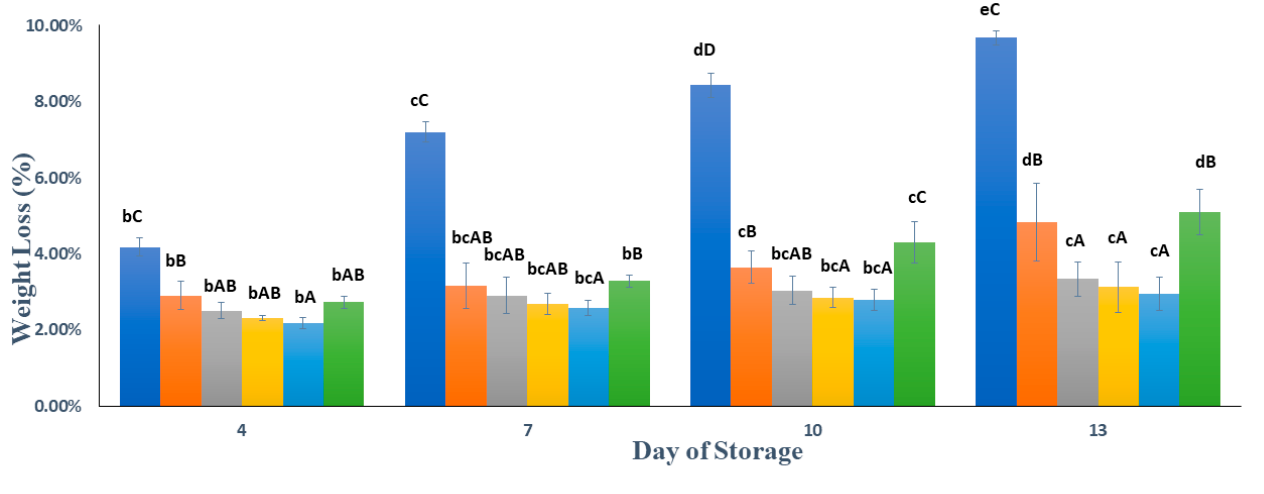
Figure 2. Effect of an edible coating of gelatin composite enriched with black tea extract on weight loss (%) of minimally processed watermelon during storage. The value shown is the average of the three experimental replications. A–D Values followed by the same capital letters showed no significant difference ( p > 0.05) between treatments on the same day. a–d Values followed by the same non-capital letters showed no significant difference ( p > 0.05) between storage times in the same treatment.